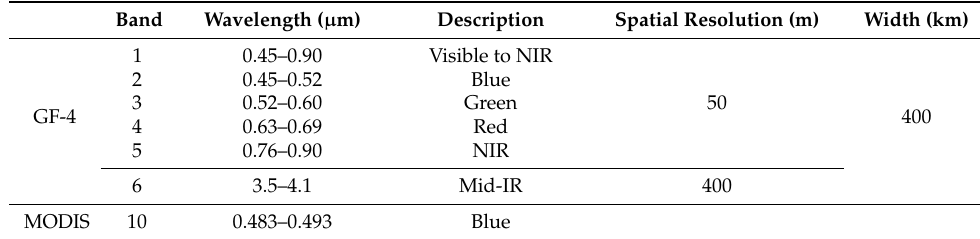
Table 1. Technical specifications of the GF-4 satellite and